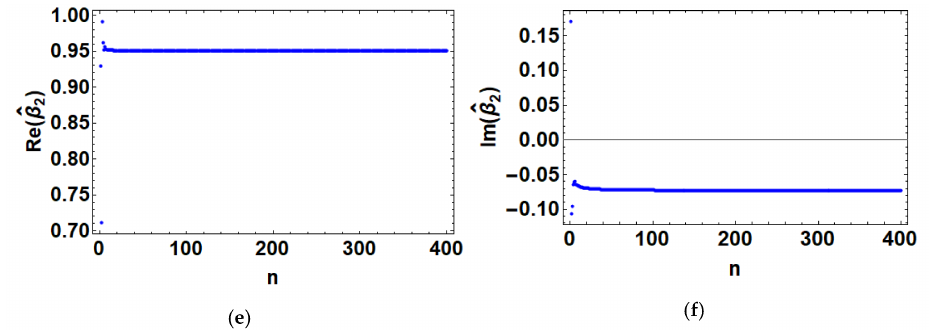
Figure 11. The real and imaginary parts of the synchronization error, ˆ β 1 and ˆ β 2 where the value of q 1 is unknown in the master system, the value of q 2 in the slave system is set to 0.433 − 0.55 i and the other values of parameters are p = 2, α = 0.85, γ = 0.3 + 0.3 i , η 1 = 0.2 and η 2 = 0.2 ( a , b ). The